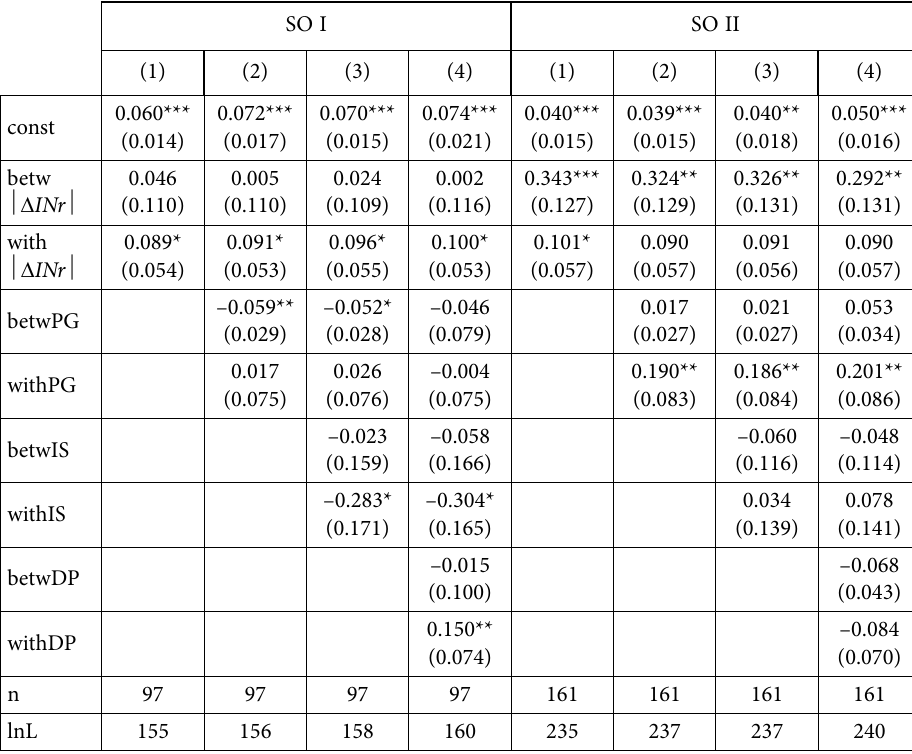
Table 4. Random-effects (GLS) estimates for Ist and IInd SO class (robust HAC standard errors, de- pendent variable D